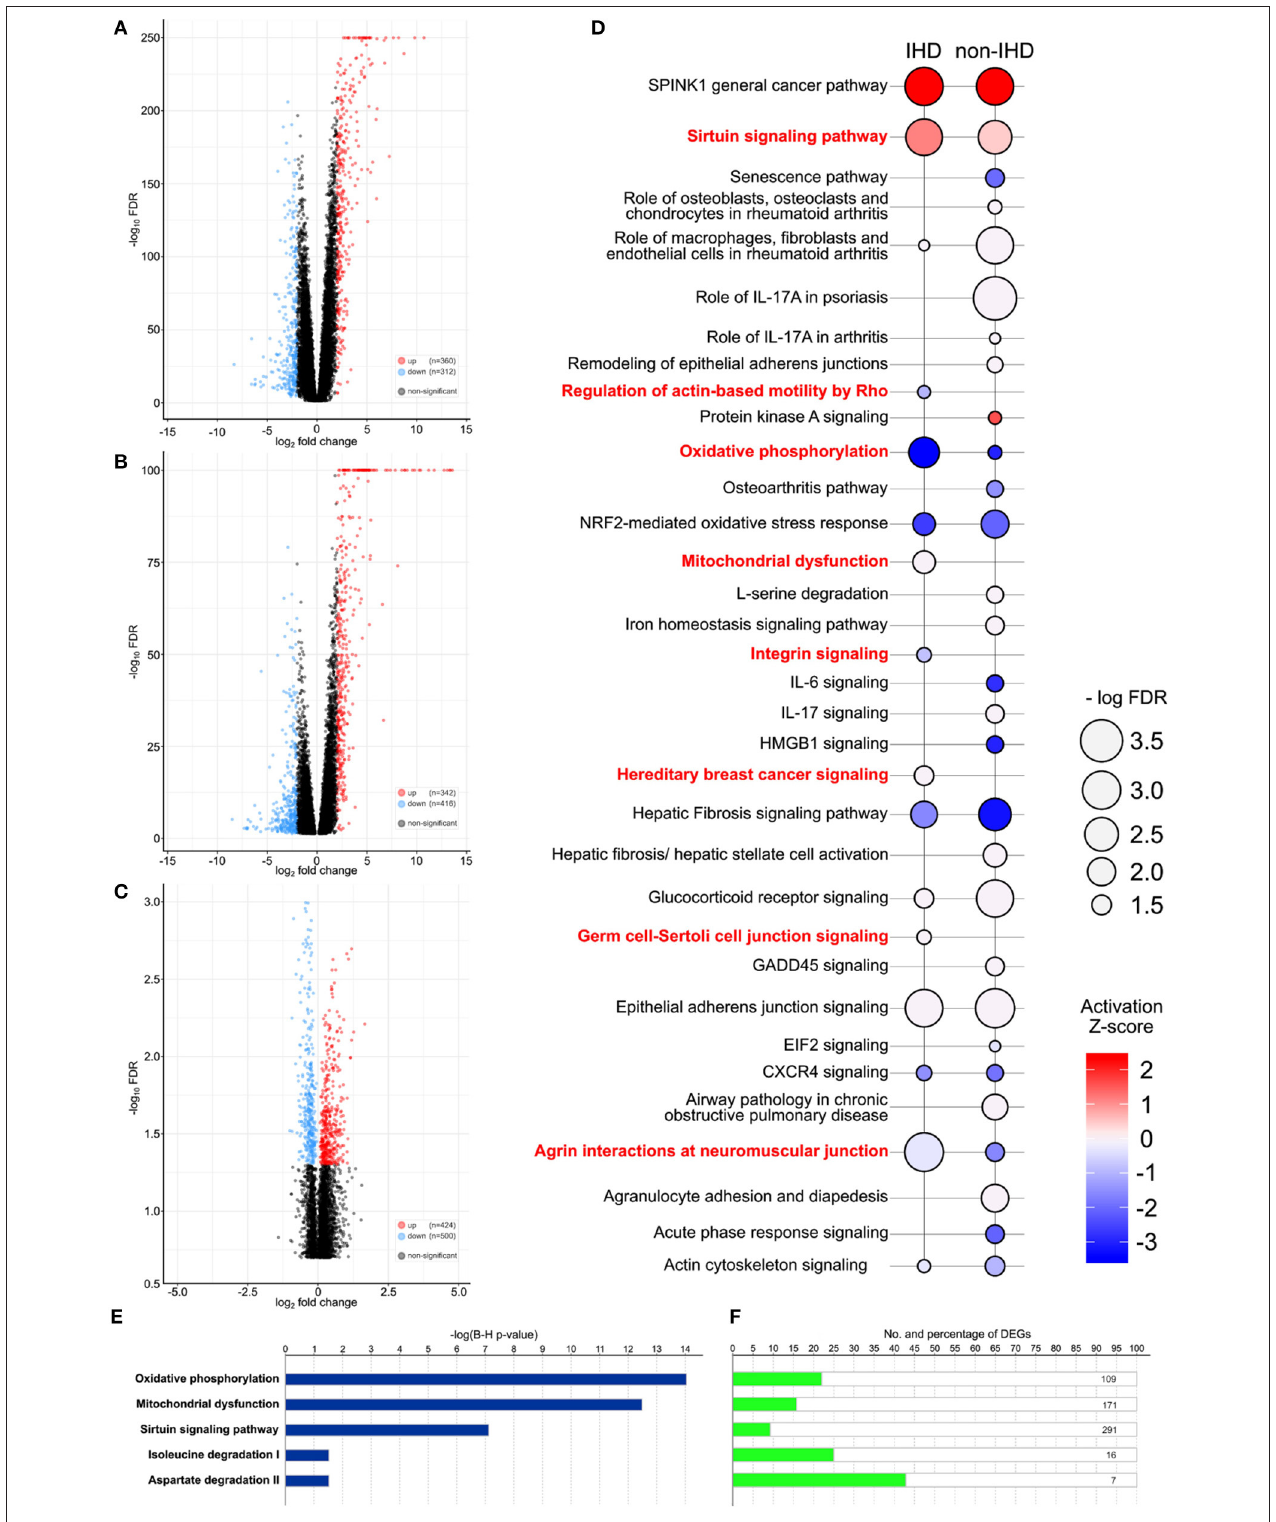
FIGURE 2 | (A–C) Volcano plots providing an overview and the number of differentially expressed genes (DEGs). IHD vs. GTEx patients (A) , non-IHD vs. GTEx patients (B) , and IHD vs. non-IHD patients (C) . (D) DEG-related pathways between IHD and non-IHD vs. GTEx comparison. Major differences are highlighted in red, with the color key showing the activation Z-score. The size of a balloon represents the –log(FDR) value. (E) P -values for the top five enriched pathways in IHD vs. non-IHD group comparisons. (F) Number of DEGs in the top five enriched pathways IHD vs. non-IHD group comparisons.